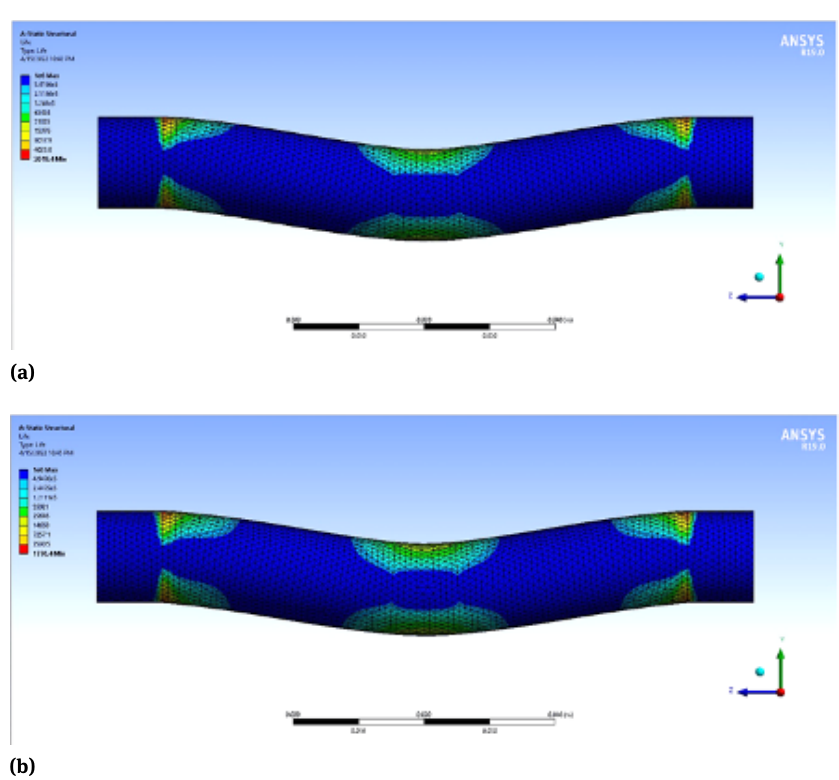
Figure 7: Life contour. (a) 0 0 0, (b) 0 0 45, (c) 0 0 90, (d) 0 45 0, (e) 0 45 90, (f) 0 90 0, (g) 45 0 0, (h) 45 45 45, (I) 90 0 0, (j) 90 45 0, (k)